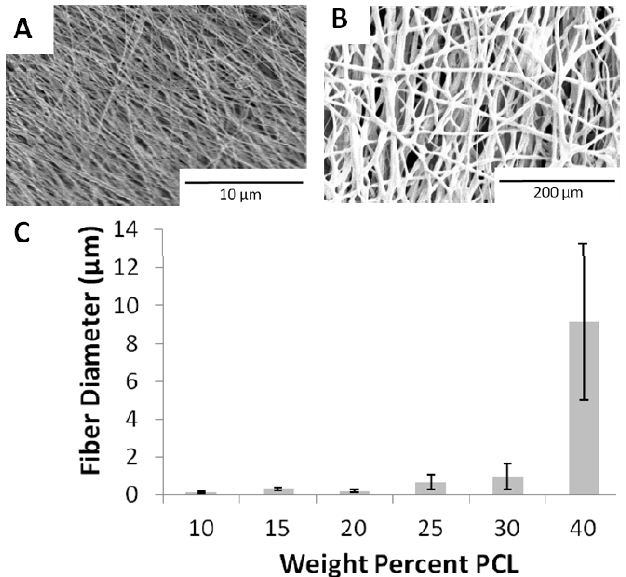
Figure 1. Scanning electron micrographs of electrospun polycaprolactone (PCL) fibers formed from solutions of varying PCL concentrations in methylene chloride and dimethylformamide (DMF) (50/50 w/w) solvent. ( A ) 20 wt % PCL; ( B ) 40 wt % PCL; ( C ) chart of PCL concentration (wt %) and fiber diameter. Data are expressed as mean ± standard